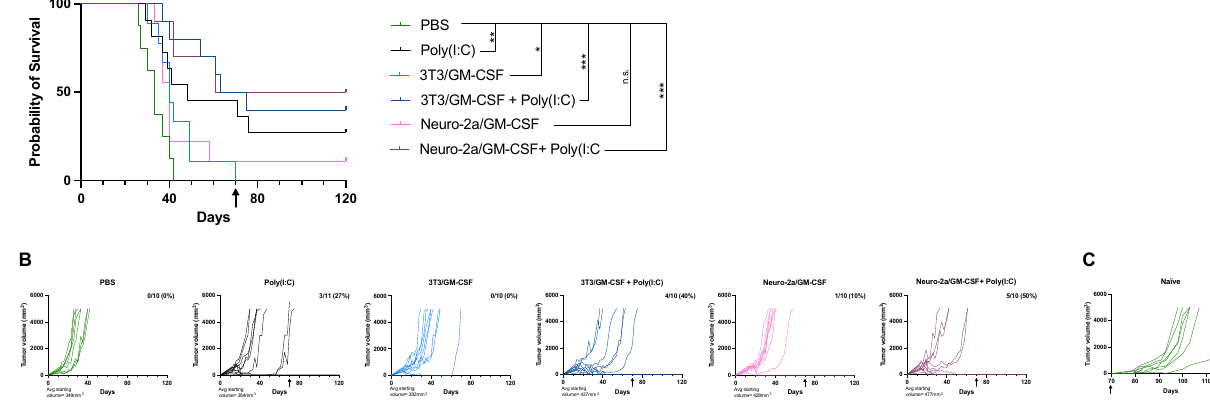
Figure 1. Intratumoral injection of Poly(I:C) with or without the addition of allogeneic GM-CSF- secreting cells into solid A20 tumors leads to tumor regression, prolongs survival, and induces long-term immunity. Tumor-bearing mice were randomized into treatment groups to allow for even distribution of tumor sizes across groups. Mice received indicated treatments twice a week for 4 weeks for a total of 8 intratumoral injections. ( A ) Kaplan-Meier survival curve of mice in each treatment group. Statistical differences were assessed using the Log rank test with the level of significance denoted by the number of asterisks: * p < 0.05, ** p < 0.01, *** p < 0.001, n.s. = not significant. ( B ) A20 lymphoma growth of individual mice in each treatment group. Tumors were sized 2–3 times per week and tumor size was calculated as described in Section 2. Mice were removed from the study when they reached a tumor size of >5000 mm 3 . ( A , B ) Tumor-free mice were challenged for a second time with A20 tumor on the opposing flank at day 70, indicated by the black arrow on graphs. ( C ) A20 tumor growth of individual naïve control mice.